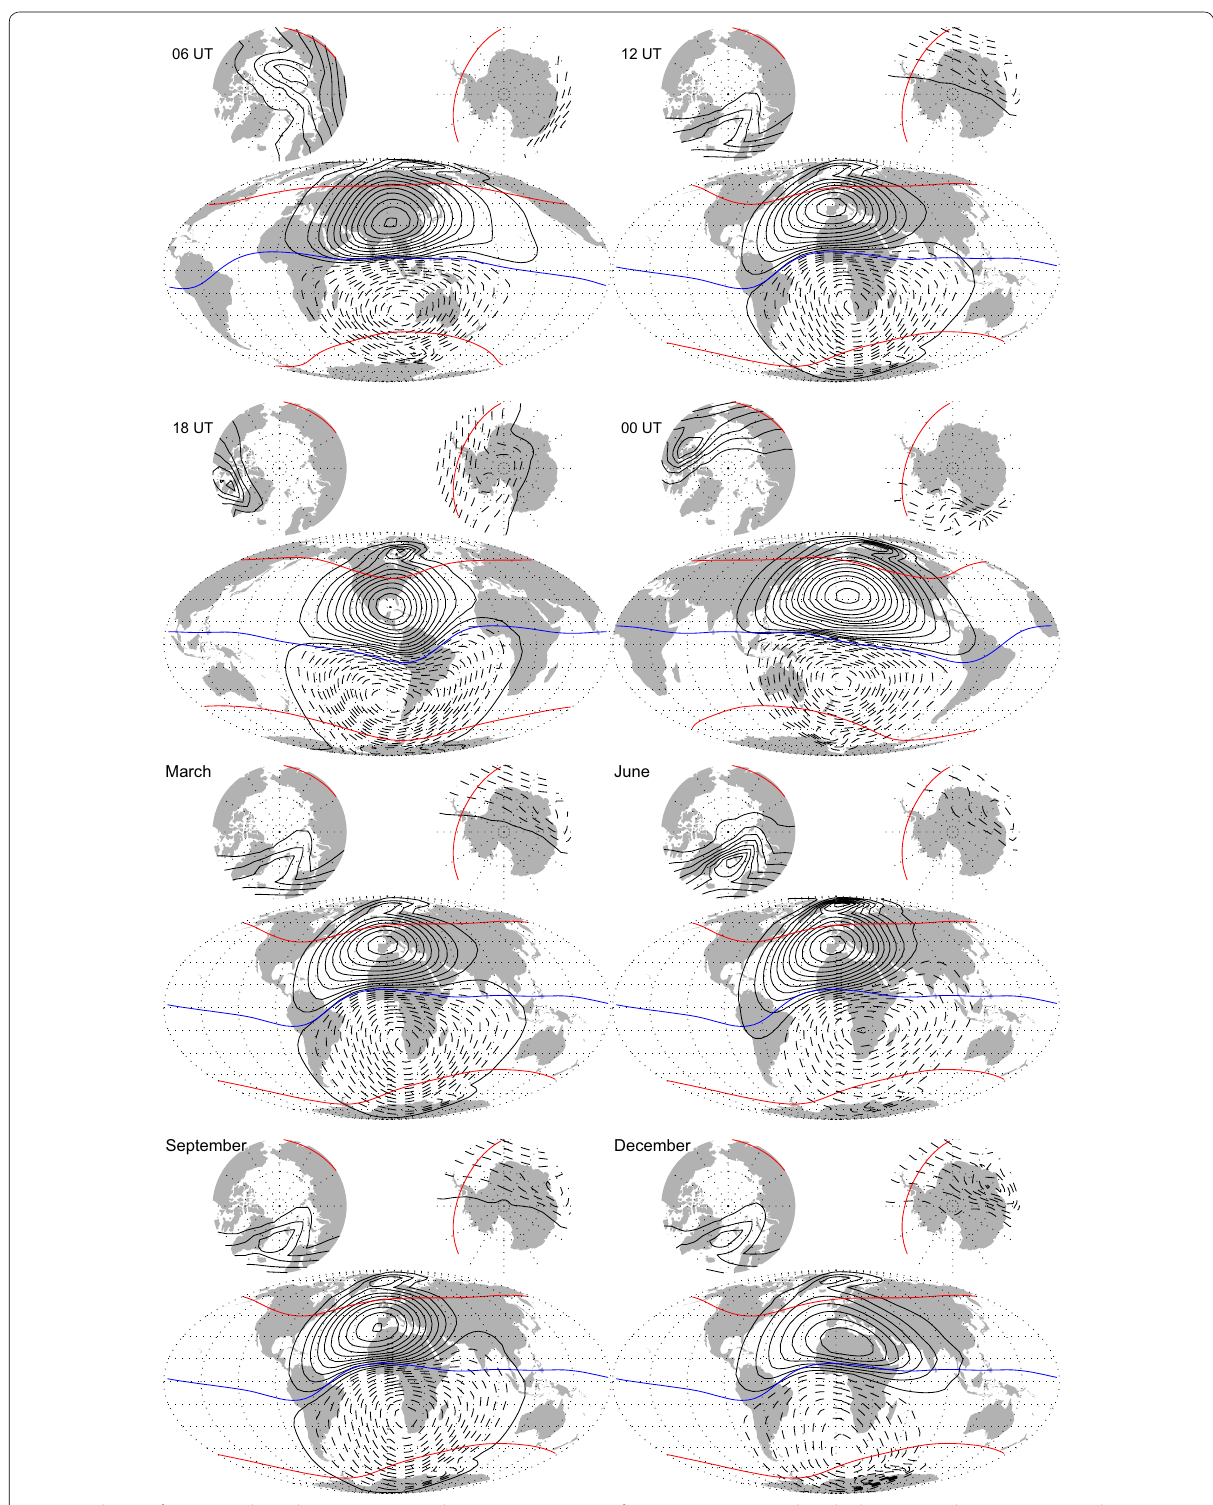
Fig. 12 The top four maps show the primary ionospheric E ‑region current function (cid:31) at 110km altitude during vernal equinox centered on noon local time for 06, 12, 18, and 00UT . The bottom four maps show (cid:31) centered at local noon and 12UT on the 21st day of March, June, September, and December. Solid/dashed contour lines indicate counter‑clockwise/clockwise current flow. A 10kA current flows between contours. Red curves represent QD latitudes of ± 55 ◦ and blue represents 0 ◦ . A value of F 10.7 = 100.0 × 10 − 22 W / m 2 / Hz was used for